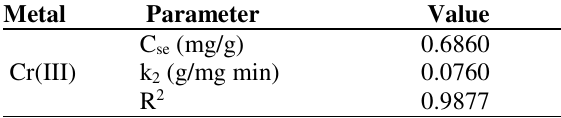
Constants corresponding to the pseudo second order for the Cr(III) sorption onto the ZVAI/ZVI mixture